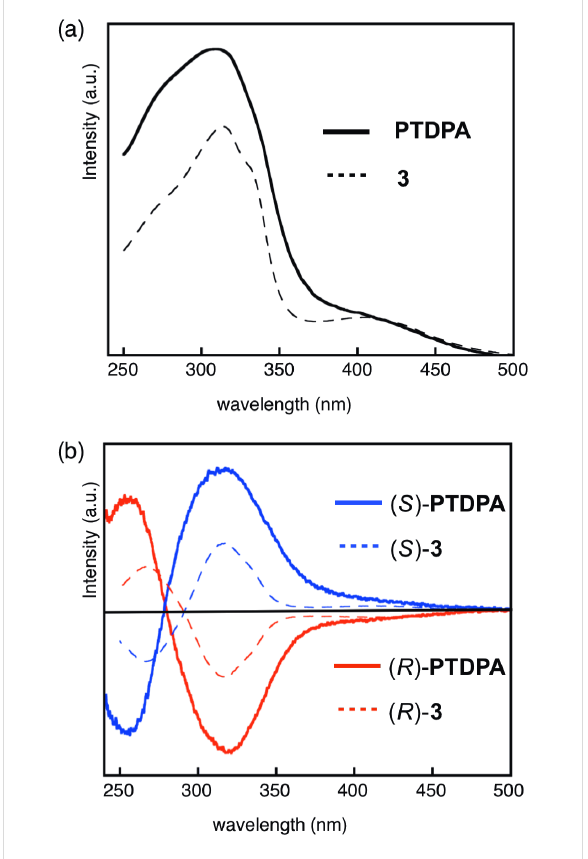
Figure 3: (a) UV–vis absorption spectra of 3 and PTDTA in CH 2 Cl 2 . (b) Normalized ECD spectra of ( R )-PTDPA, ( S )-PTDPA, ( R )- 3 , and ( S )- 3 in CH 2 Cl 2